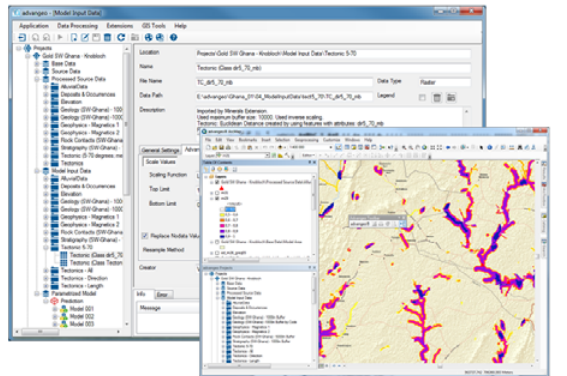
Figure 2. Software advangeo® graphical user interfaces: Data and Modell Explorer (left) and GIS Extension